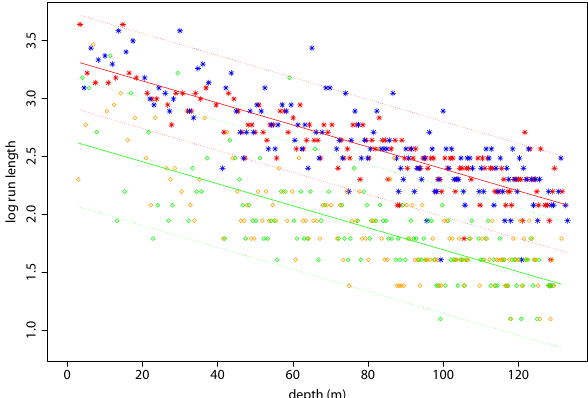
Fig. 5. A linear model for the logarithm of the length of a certain run – a set of consecutive observations that can be definitely clas- sified as belonging to the same part of an annual cycle – against depth within the Gomez core with ν = 0 . 5 and β = 6. Runs repre- senting peaks (labelled P in main text) are represented by red stars, descending runs (D) by orange circles, troughs (T) by blue stars, and ascending runs (A) by green circles. The solid lines indicate the fitted values for peak/trough runs (red) and ascending/descending runs (green), and the red and green dotted lines represent the re- spective 95% predictive intervals for individual